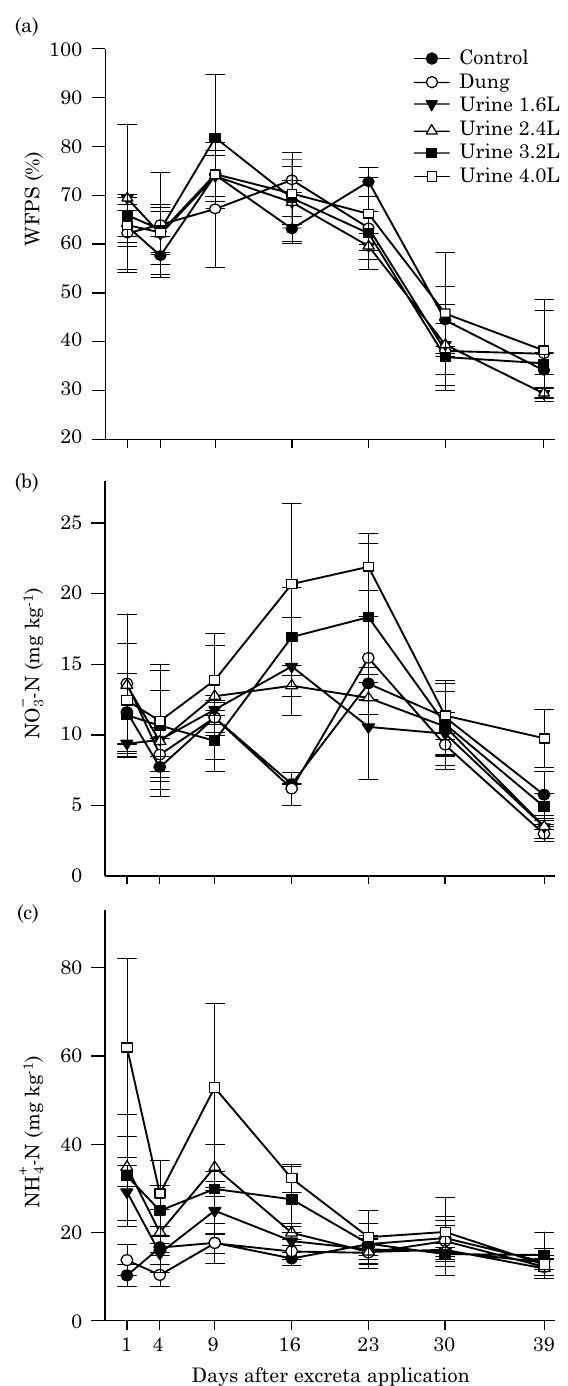
Figure 3. Water-filled pore space-WFPS (a), soil N o - 3 -N (b), and N h + 4 -N (c) after sheep urine and dung application in a subtropical Argissolo Vermelho Distrófico típico (typic Paleudult) under italian ryegrass pasture. urine was applied at four rates (1.6, 2.4, 3.2, and 4.0 l m -2 ), with 2.4 l m -2 being the mean volume per urination. dung was applied at a rate of 0.135 kg m -2 of dry matter, which is twice the mean weight per defecation. Bars represent the standard